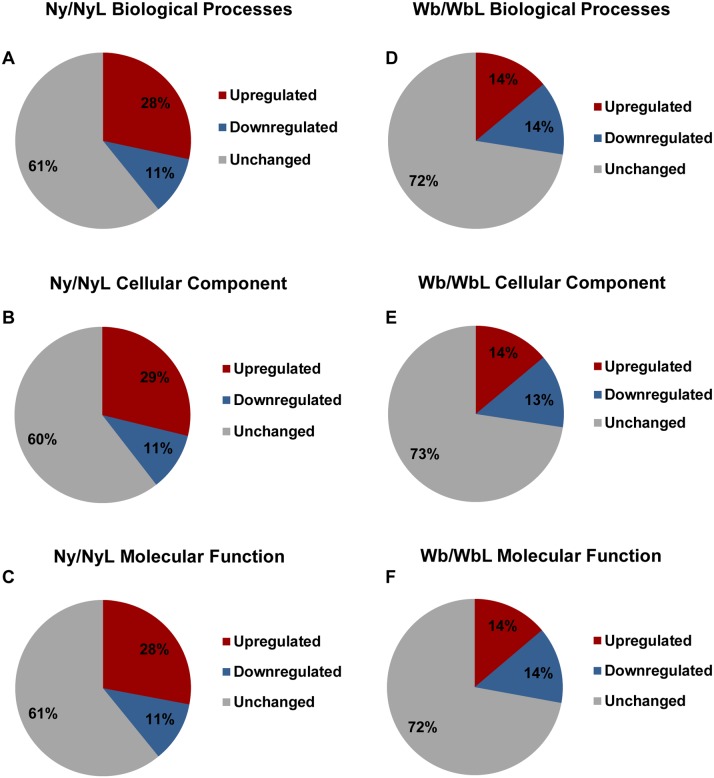
The distribution of up- or down-regulated genes among the major Gene Ontology (GO) categories.(A-C), showing the proportion of color-coded Asian citrus psyllid contigs for each group, as follows: up-regulated (red), down-regulated (blue), and unchanged (grey), in response to Ca. Liberibacter asiaticus (CLas) infection of nymphs (Ny), based on the Biological Process, Cellular Components and Molecular Functions GO categories. Distribution of contigs with altered expression in the GO categories, Biological Process, Cellular Components and Molecular Functions (D-F) of up-regulated (red), down-regulated (blue), and unchanged (grey) candidates, in response to CLas infection of ACP adults (Wb). Contigs classified into GO categories were identified as differentially expressed using p-value cut off 0.05 (edgeR statistics).